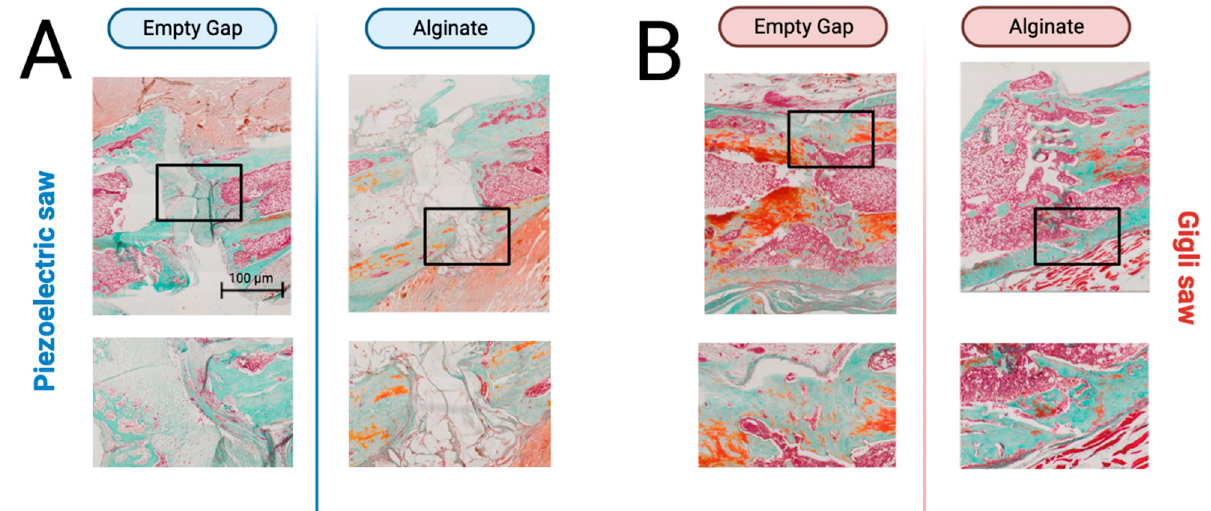
Figure 6. Representative histological sections of the fracture defect area for all treatment groups stained either with Masson–Goldner (bottom) stain. ( A ) Fracture creation with the piezoelectric saw and the ( B ) Gigli saw. The bottom row shows enlarged sections (box) of the fracture defect area.